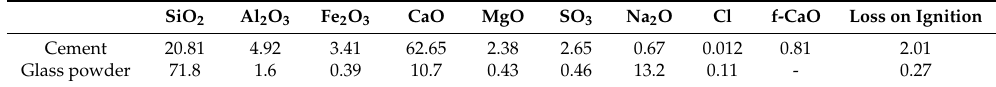
Table 2. Chemical composition of P.I 42.5 cement and glass powder (wt %).